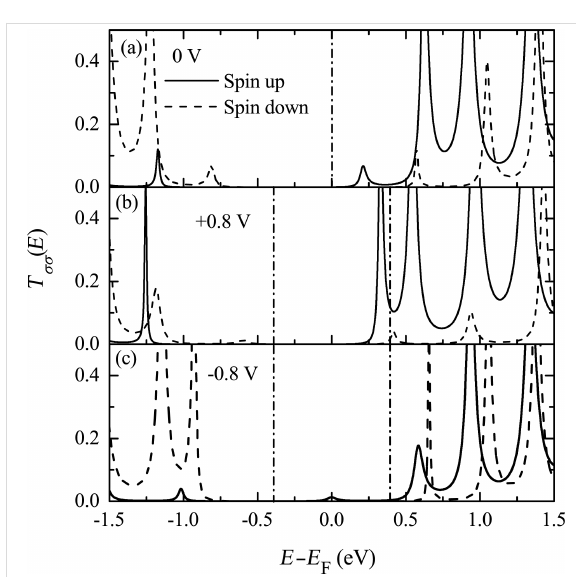
Figure 11: Spin-dependent transmission near the Fermi energy for N = 32 and E F = 0.3 eV at the bias voltages (a) 0 V, (b) +0.8 V, and (c) − 0.8 V. Reproduced with permission from [33], copyright 2008 AIP